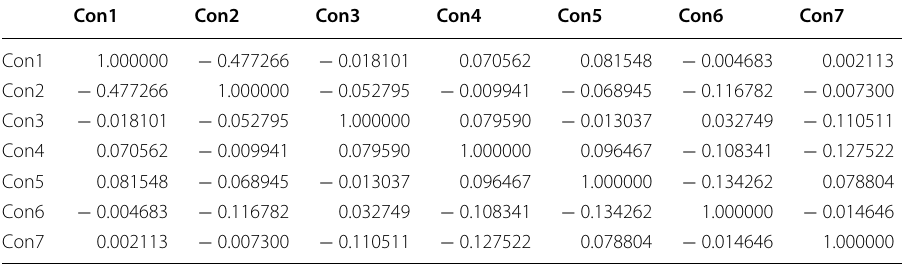
Table 5 Correlation coefficient utilizing the dataset of user U2